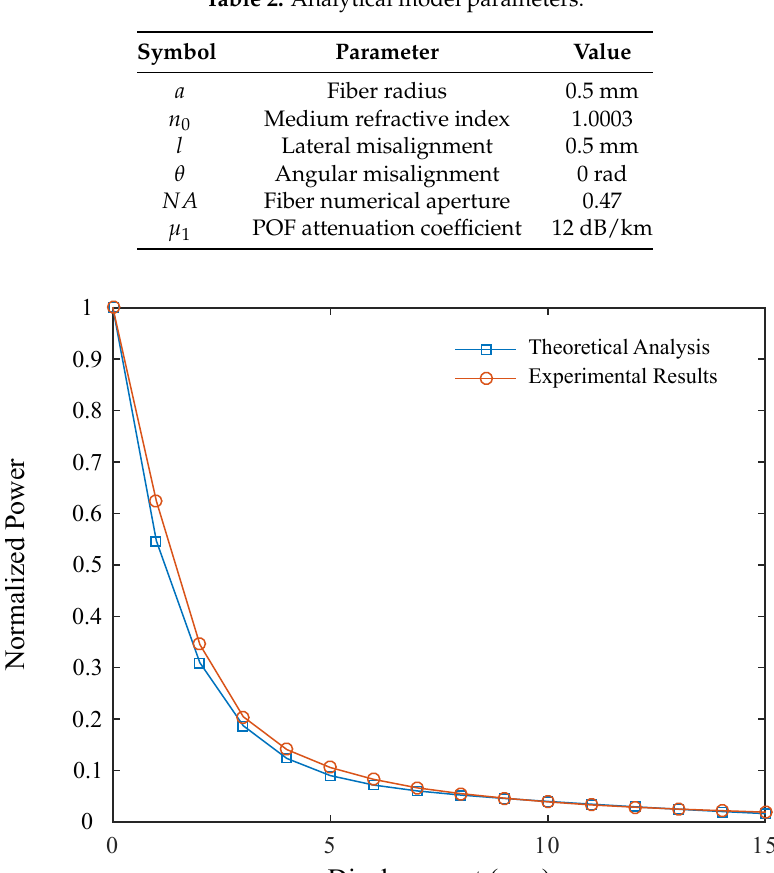
Table 2. Analytical model parameters.